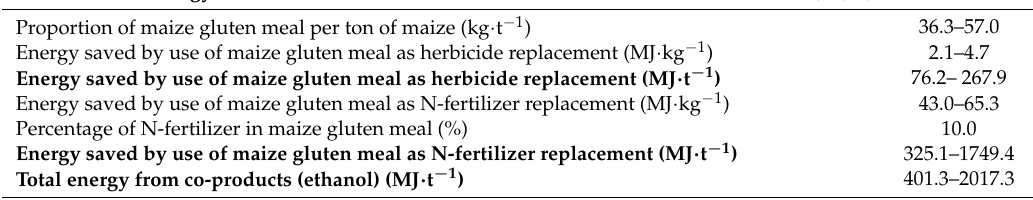
Table 3. Conversion factors for estimating the energy saved from co-product reintegration into agricultural